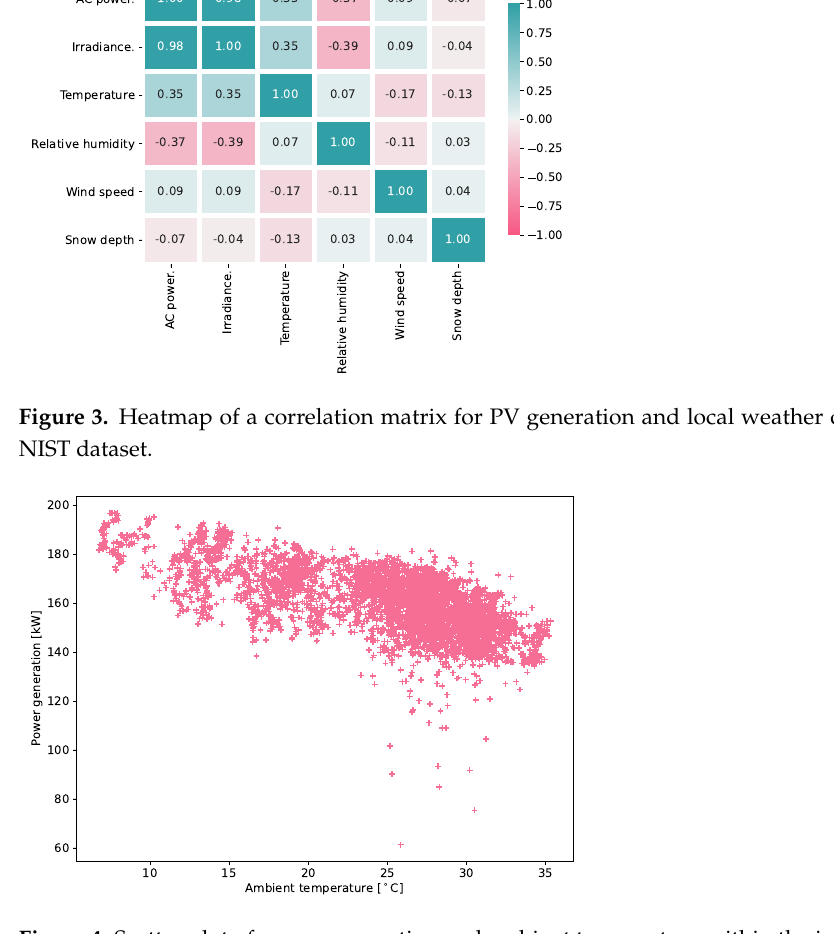
Figure 4. Scatter plot of power generation and ambient temperature within the irradiance interval (600 ∼ 700 [W/m 2 ]).